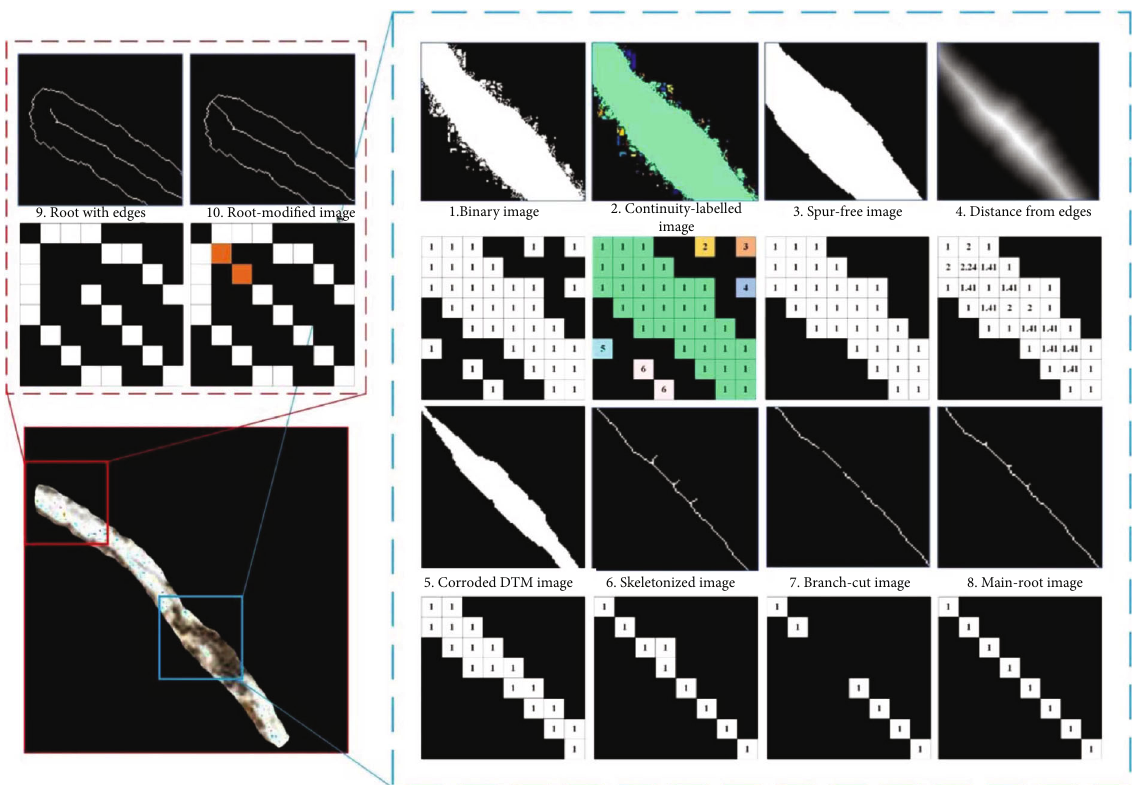
Figure 12: Schematic diagram of the proposed quanti fi cation algorithm in details.